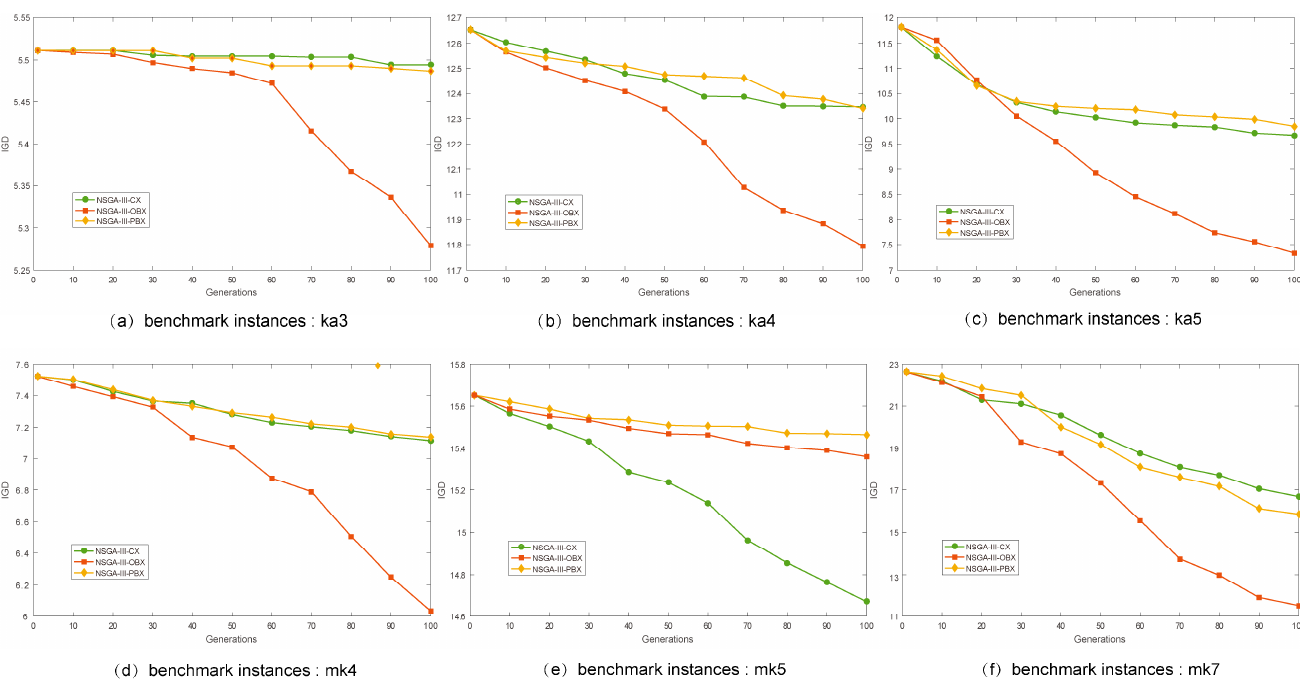
Figure 4. At population size of 200, the evolutionary trajectory of the inverted generational distance (IGD) for the NSGA-III variants on the six FJSP instances (the average of the results of 30 independent runs; the initial population is the population close to the Pareto front in the target space).